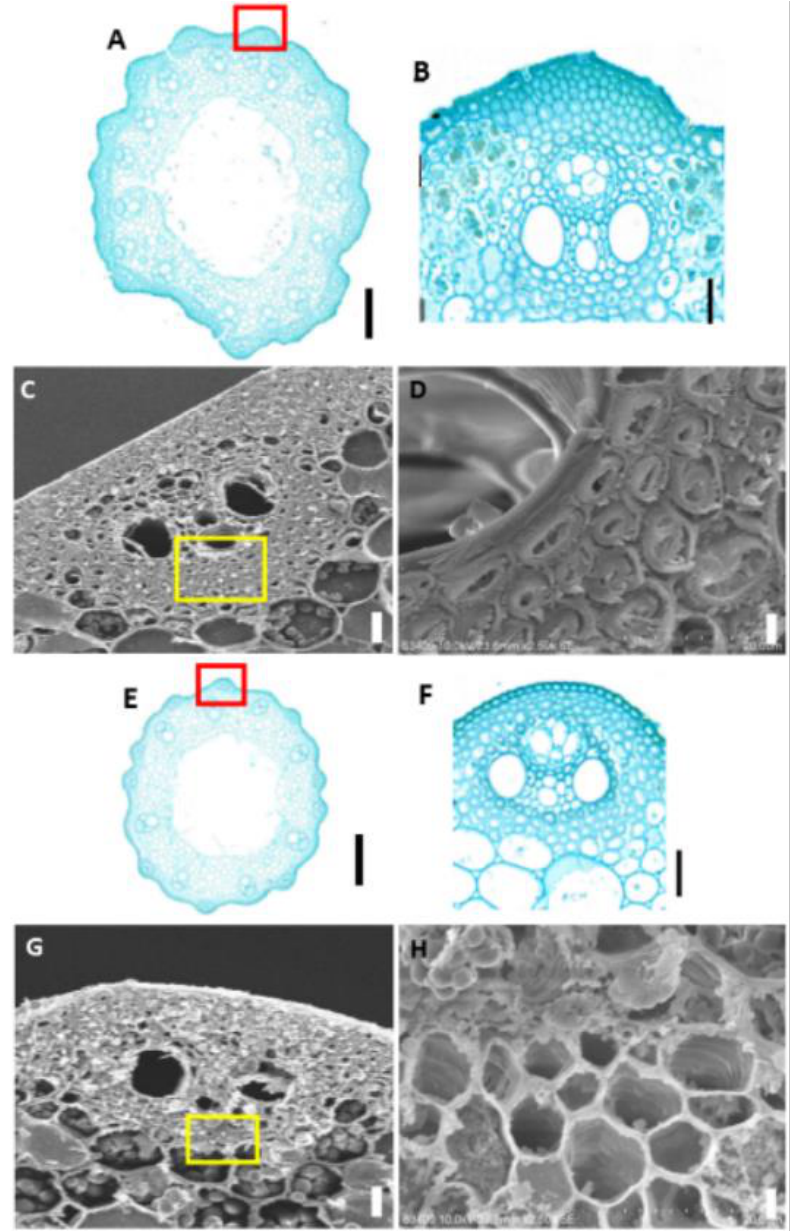
Figure 2. ( A , B , E , F ) Paraffin sections of stems of the Pingtangheinuo wild type (WT) and osbc17 brittle stem mutant. ( A , E ) Transverse sections of whole stem segments of the WT ( A ) and the brittle stem mutant ( E ). The red boxes in ( A , E ) are enlarged to show ( B , F ), respcetively. ( B , F ) Local enlargements of epidermis of the WT ( B ) and brittle stem mutant ( F ). Bar = 1 mm ( A , E ) or 20 µ m ( B , F ). ( C , D , G , H ) Scanning electron microscopic images of wild-type (WT) Pingtangheinuo and brittle stem mutant osbc17 internodes. ( C , G ) Transverse sections of stems of the WT ( C ) and the brittle stem mutant ( G ). The yellow boxes in ( C , G ) are enlarged to show ( D,H ), respcetively. ( D,H ) Local enlargements of stems of the WT ( D ) and the brittle stem mutant ( H ). Bar = 20 µ m ( C , G ) or 4 µ m ( D , H